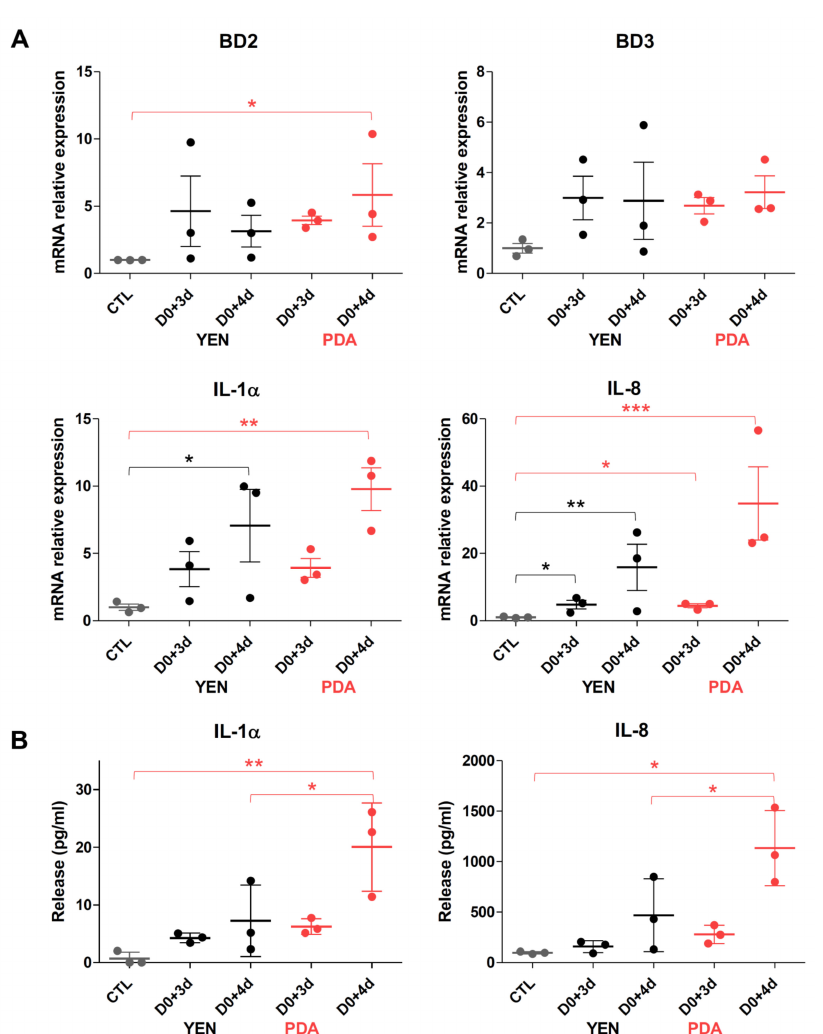
Figure 6. Keratinocytes responses during T. benhamiae IHEM 20163 infection on reconstructed human epidermis (RHE). RHE were infected on day zero (D0) by topical addition of inoculum consisting in suspensions of T. benhamiae IHEM 20163 spores recovered after 21 days of incubation over Yeast Extract Nitrogen agar (YEN) at 30 ◦ C under 12% CO 2 , or after 10 days of incubation over Potato Dextrose Agar (PDA) in the same conditions. The inoculum has been adjusted in each case to a density of 30 colony-forming units (CFU) per RHE. ( A ) mRNA expression of antimicrobial peptides (BD2, BD3) and pro-inflammatory cytokines (IL-1 α , IL-8) and ( B ) release of IL-1 α and IL-8 by infected RHE, three (D0+3d) and four (D0+4d) days after infection, or by non-infected RHE (CTL) were assessed respectively by RT-qPCR and ELISA. Data analysis: n = 3; means ± SD; ANOVA2; * p < 0.05 ** p < 0.01 *** p <